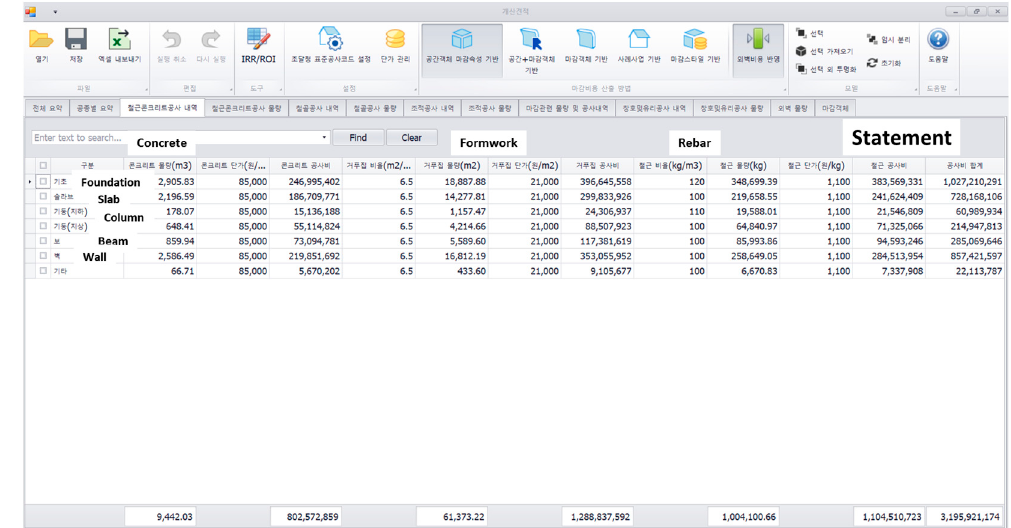
Figure 11. Estimated construction cost result screen: part of the construction cost.